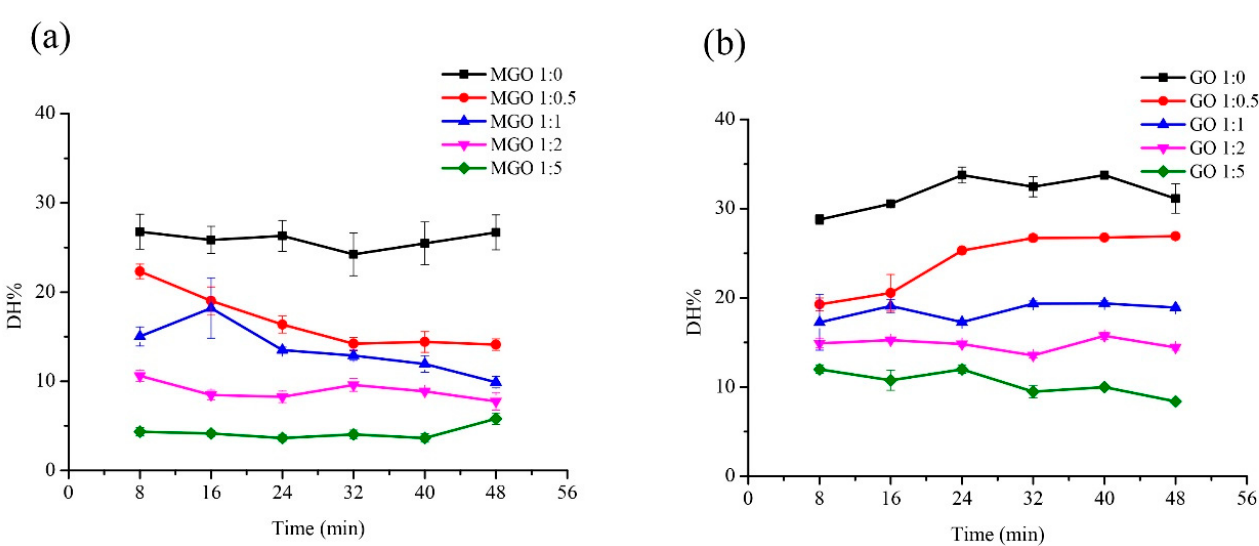
Figure 1. Effect of reactant mass ratio and duration on the digestibility of glycated glutenin derived from MGO and GO. ( a ) Glutenin (1 mg/mL) with MGO (40% aqueous solution) was incubated under different mass ratio of glutenin to MGO (1:0, 1:0.5, 1:1, 1:2, 1:5) at 100 ◦ C for 8, 16, 24, 32, 40, and 48 min, respectively. ( b ) Glutenin (1 mg/mL) with GO was incubated under different mass ratio of glutenin to GO (1:0, 1:0.5, 1:1, 1:2, 1:5) at 100 ◦ C for 8, 16, 24, 32, 40, and 48 min, respectively. Data show the means ± SD of triplicate independent experiments. Bars represent the standard error of the mean.